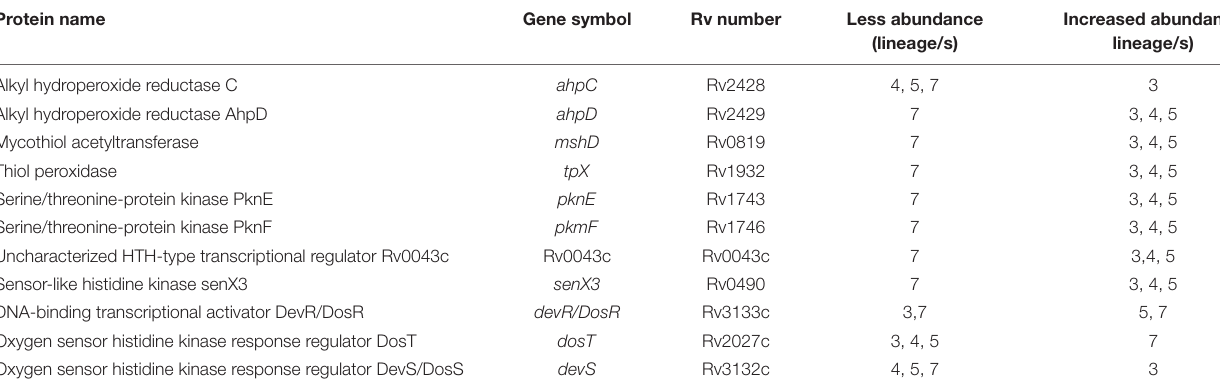
TABLE 6 | Differentially abundant metabolic stress response and regulatory proteins in MTBC